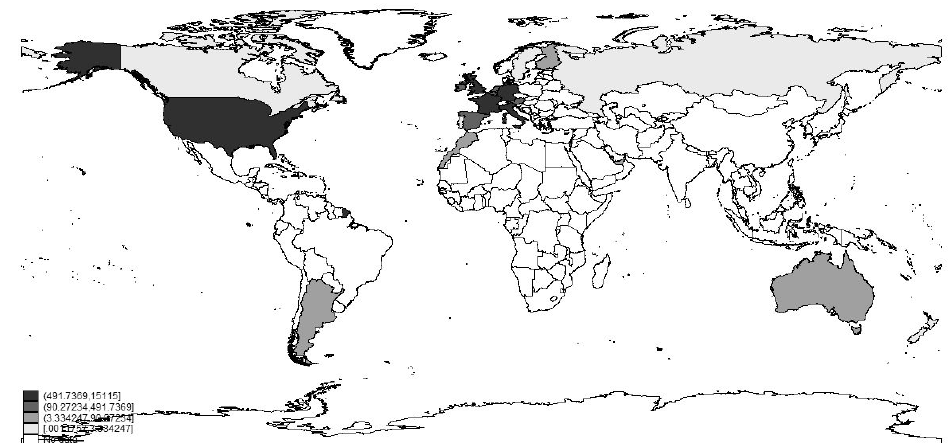
Figure 1. Box plot for the price logarithm.